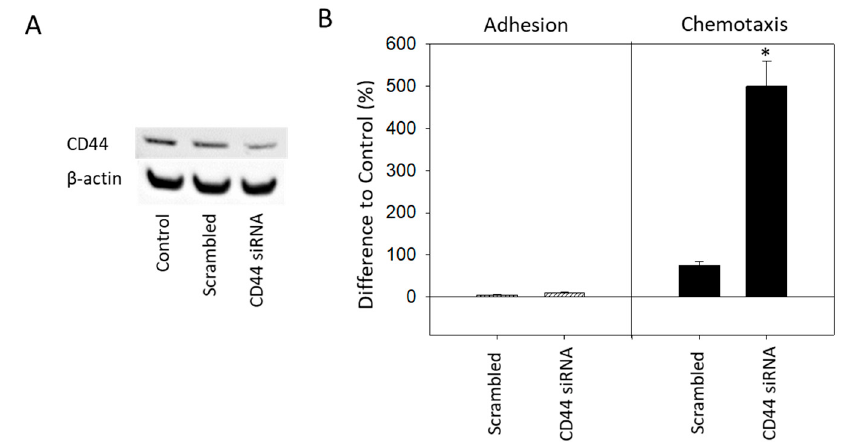
Figure 4. Functional knock-down of CD44 in untreated RT112 cells (Control). AllStars Negative Control siRNA served as transfection control (Scrambled). ( A ) Protein expression after functional blocking with siRNA targeting CD44. β -actin served as internal control. One representative of three separate experiments is shown. ( B ) Tumor cell adhesion and chemotaxis of CD44-blocked RT112 cells. Means ± SD of n = 3. * indicates significant difference to control, p ≤ 0.05.